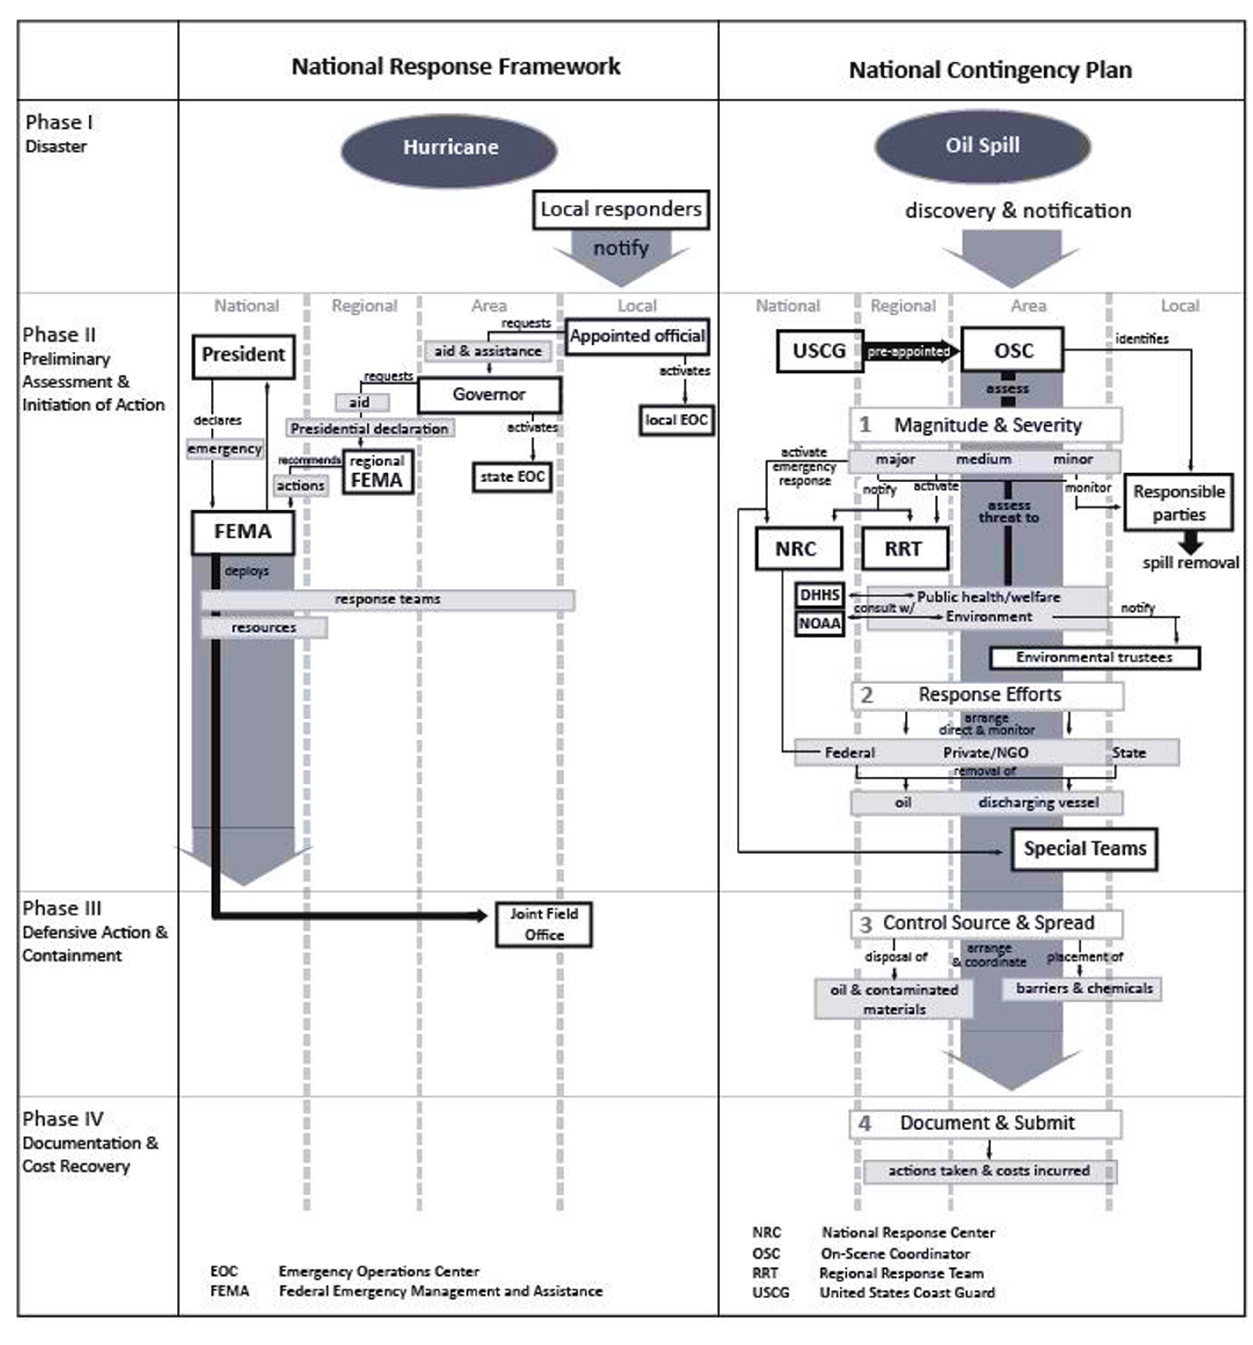
Fig. 1 . National Response Framework vs. National Contingency